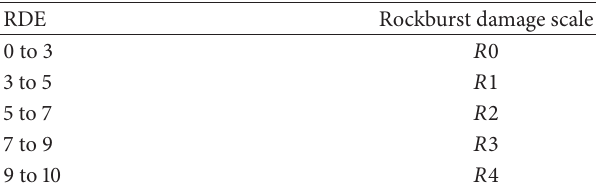
Table 6: Rockburst damage potential